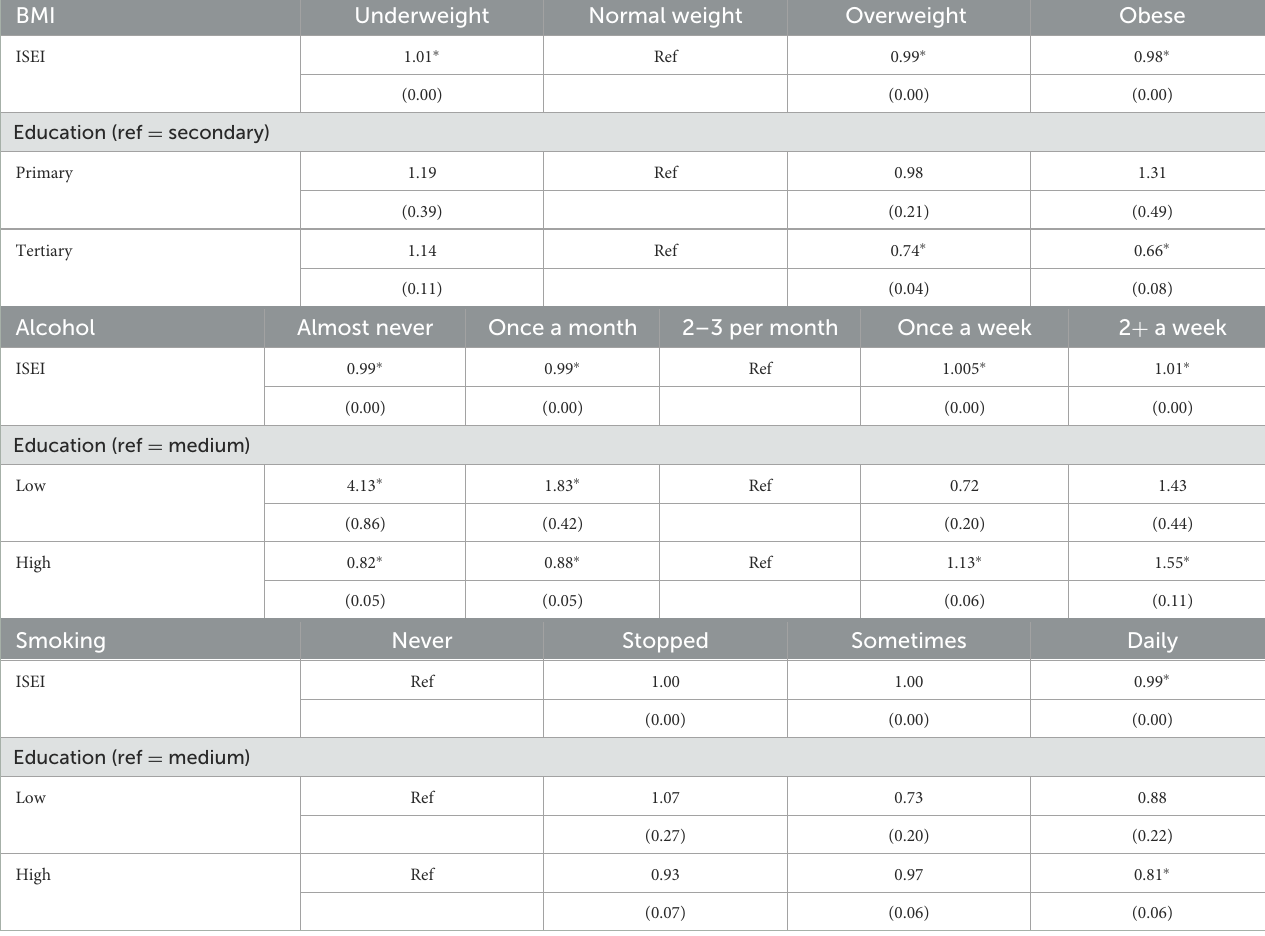
TABLE 4 Multinomial logistic regression analyses between health-related behavior and socio-economic background of parents. BMI Underweight Normal weight Overweight Obese